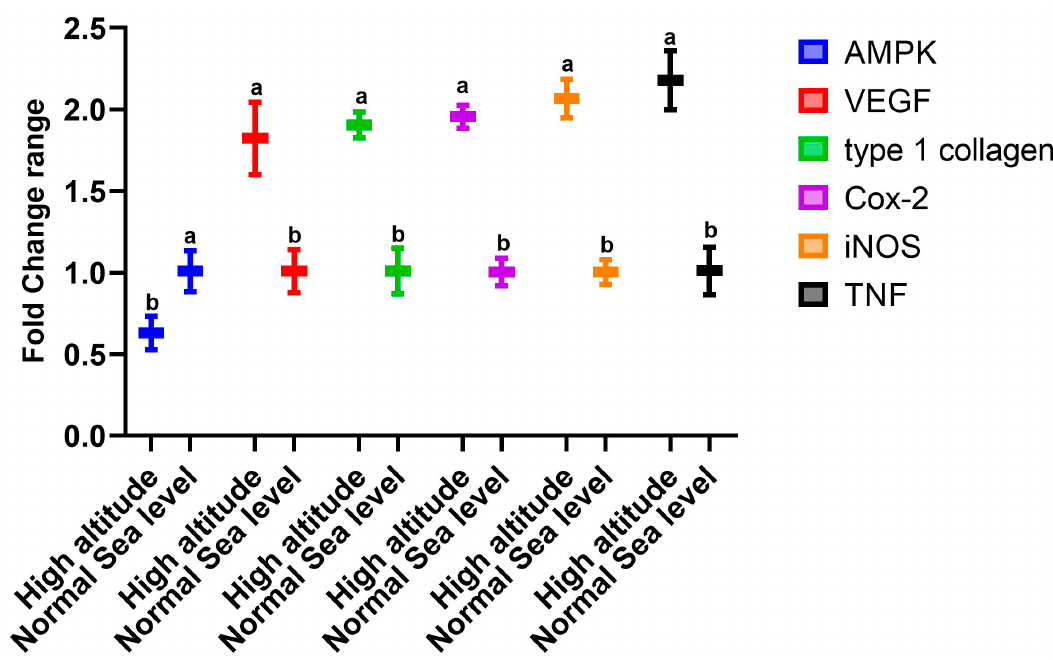
Figure 1. Impacts of high altitude on the expression levels of hepatic oxidative stress marker genes associated with hypoxia in the liver as assessed using quantitative real-time PCR. Bars indicate densitometric analysis of the expression levels of the examined genes for 10 different rats per group. Bars with different letters indicate significant differences between groups A (normal sea level) and B (high altitude) at p < 0.05.